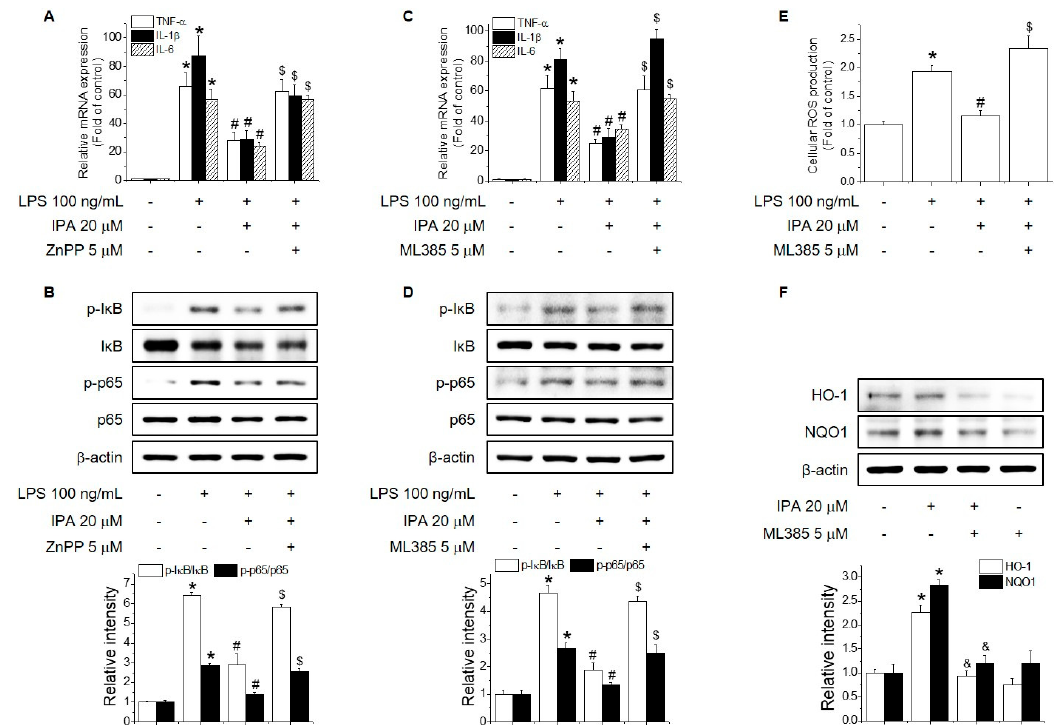
Figure 5. Role of Nrf2 in the inhibitory effect of IPA on LPS-induced inflammation. ( A , C ) RAW264.7 cells were cultured with 5 μ M ZnPP or ML385 for 1 h before adding 20 μ M IPA for 12 h, followed by 100 ng/mL LPS for 6 h. TNF- α , IL-1 β , and IL-6 expression were analyzed by real-time PCR. ( B , D ) RAW264.7 cells were cultured with 5 μ M ZnPP or ML385 for 1 h before adding 20 μ M IPA for 1 h, followed by 100 ng/mL LPS for 1 h. The phosphorylation levels of I κ B and NF- κ B were determined by Western blotting. ( E ) RAW264.7 cells were cultured with 5 μ M ZnPP or ML385 for 1 h before adding 20 μ M IPA for 12 h, followed by 100 ng/mL LPS for 24 h. The ROS levels was assayed using H 2 DCF-DA. ( F ) RAW264.7 cells were cultured with 5 μ M ML385 for 1 h before adding 20 μ M IPA for 12 h. * Significantly different from the control at p < 0.01. # Significantly different from the LPS treatment group at p < 0.01. $ Significantly different from the LPS and IPA treatment group at p < 0.01. & Significantly different from the IPA treatment group at p < 0.01.